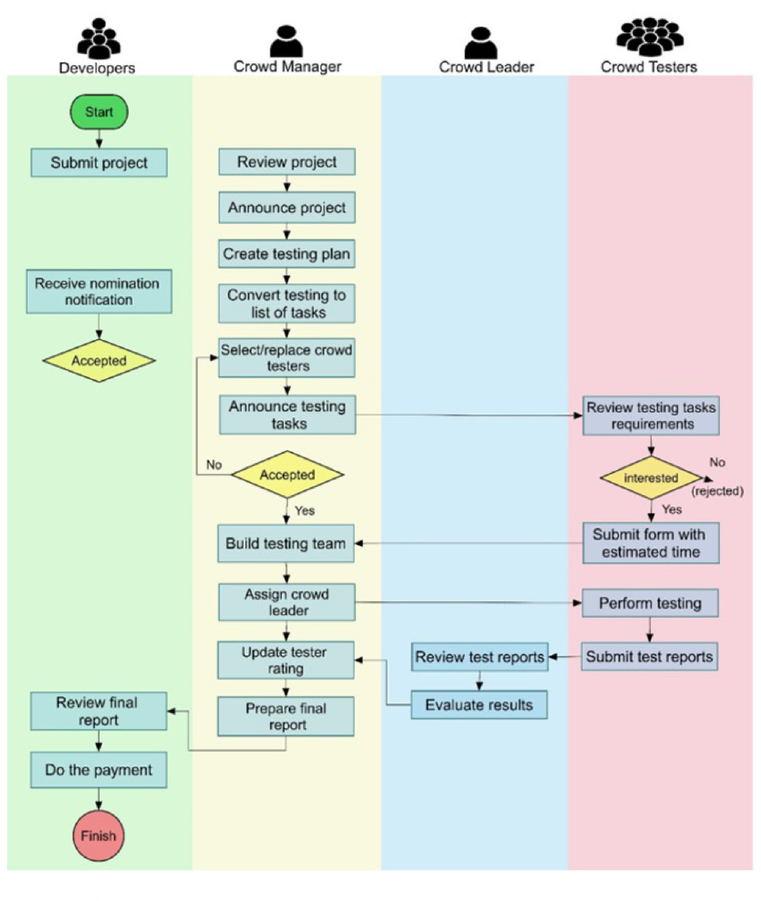
Figure 1. The common crowdsourced